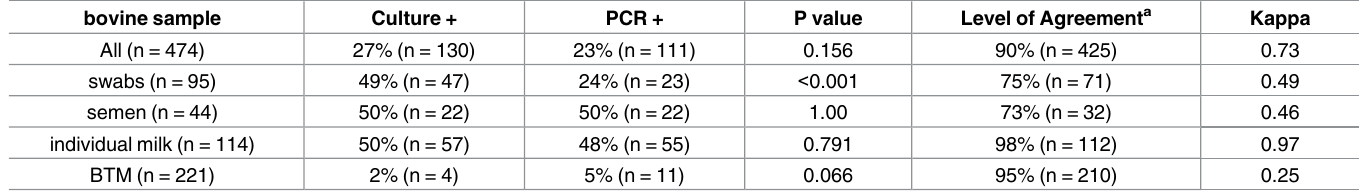
Table 4. Comparison of culture and multiplex PCR for detecting bovine field samples as positive or negative for M . bovis , M . californicum or M . bovigenitalium